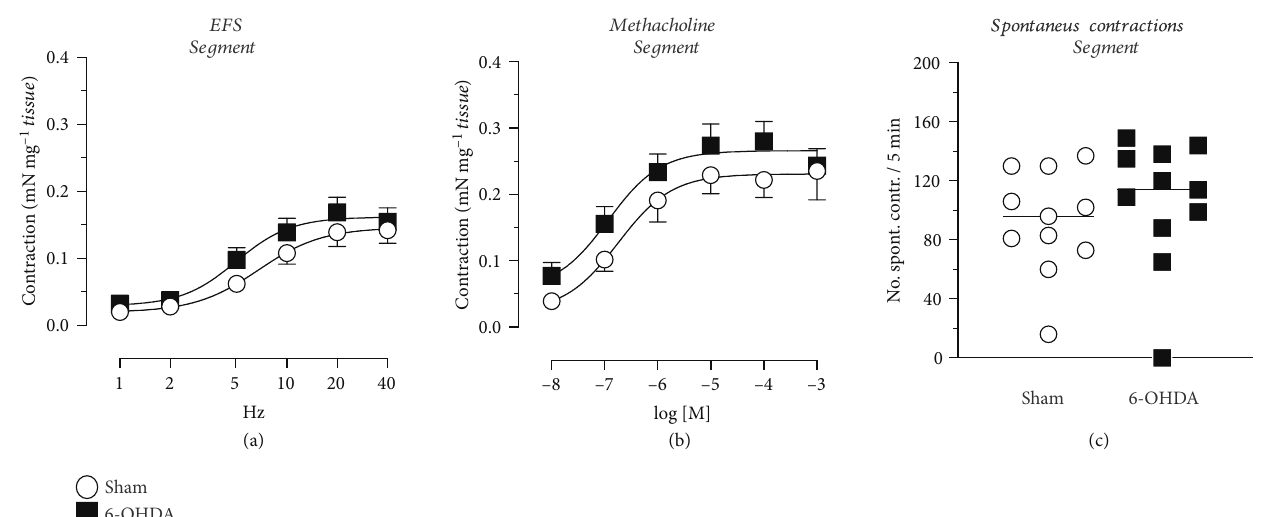
Figure 5: Electrical fi eld stimulation (EFS) and methacholine-induced contractions in distal ileum segments. No signi fi cant di ff erence in the smooth muscle contractility (mNmg − 1 ) was observed after either EFS (a: Sham n = 10 ; 6-OHDA, n = 9 ) or methacholine (b: Sham n = 11 ; 6- OHDA, n = 11 ). In addition, the frequency of the spontaneous contraction was unaltered by 6-OHDA-induced dopamine lesions (c: Sham n = 11 ; 6-OHDA, n = 11